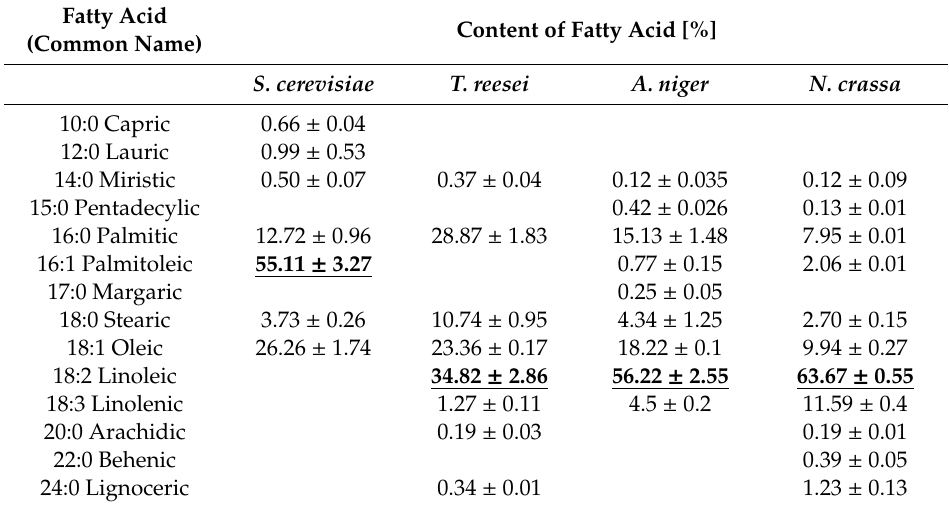
Table 3. Profile of fatty acids in membranes from yeast and filamentous fungi.